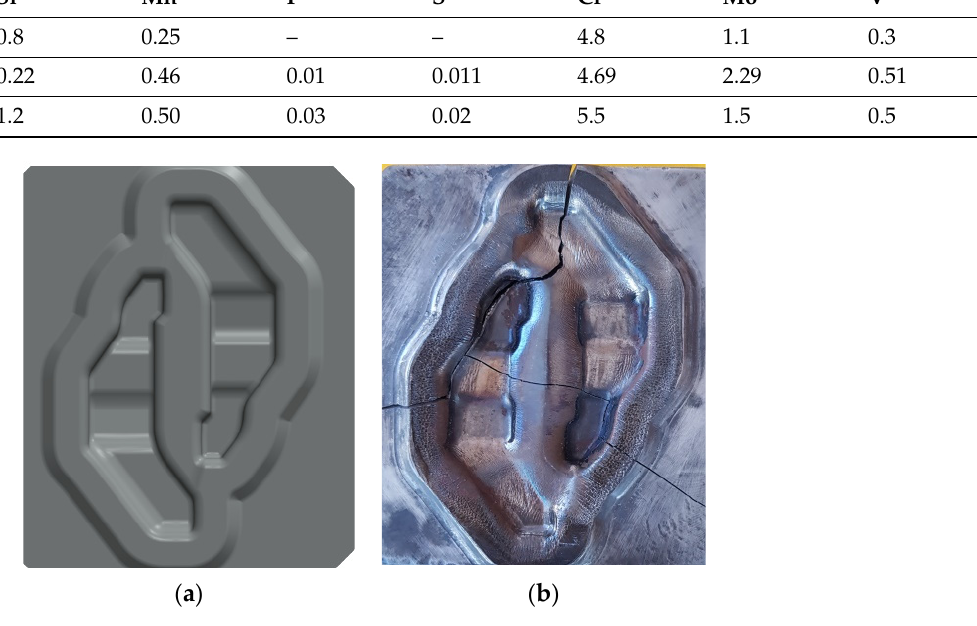
Figure 1. The view of: ( a ) geometric model of the designed die inserts for pre-forming in a double forging system and ( b ) the insert in post-operation period. Table 1. Chemical composition (% by mass) of the tool material in relation to the EN ISO 4957: 2018 standard.